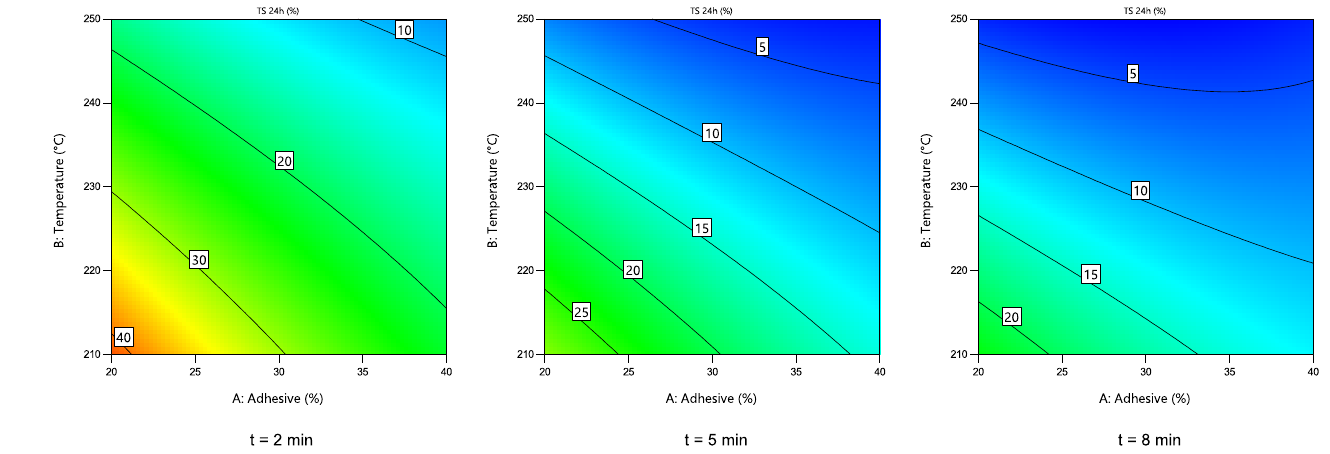
Figure 7. Changes in the TS 24 h value of the boards depending on the hot-pressing parameters.